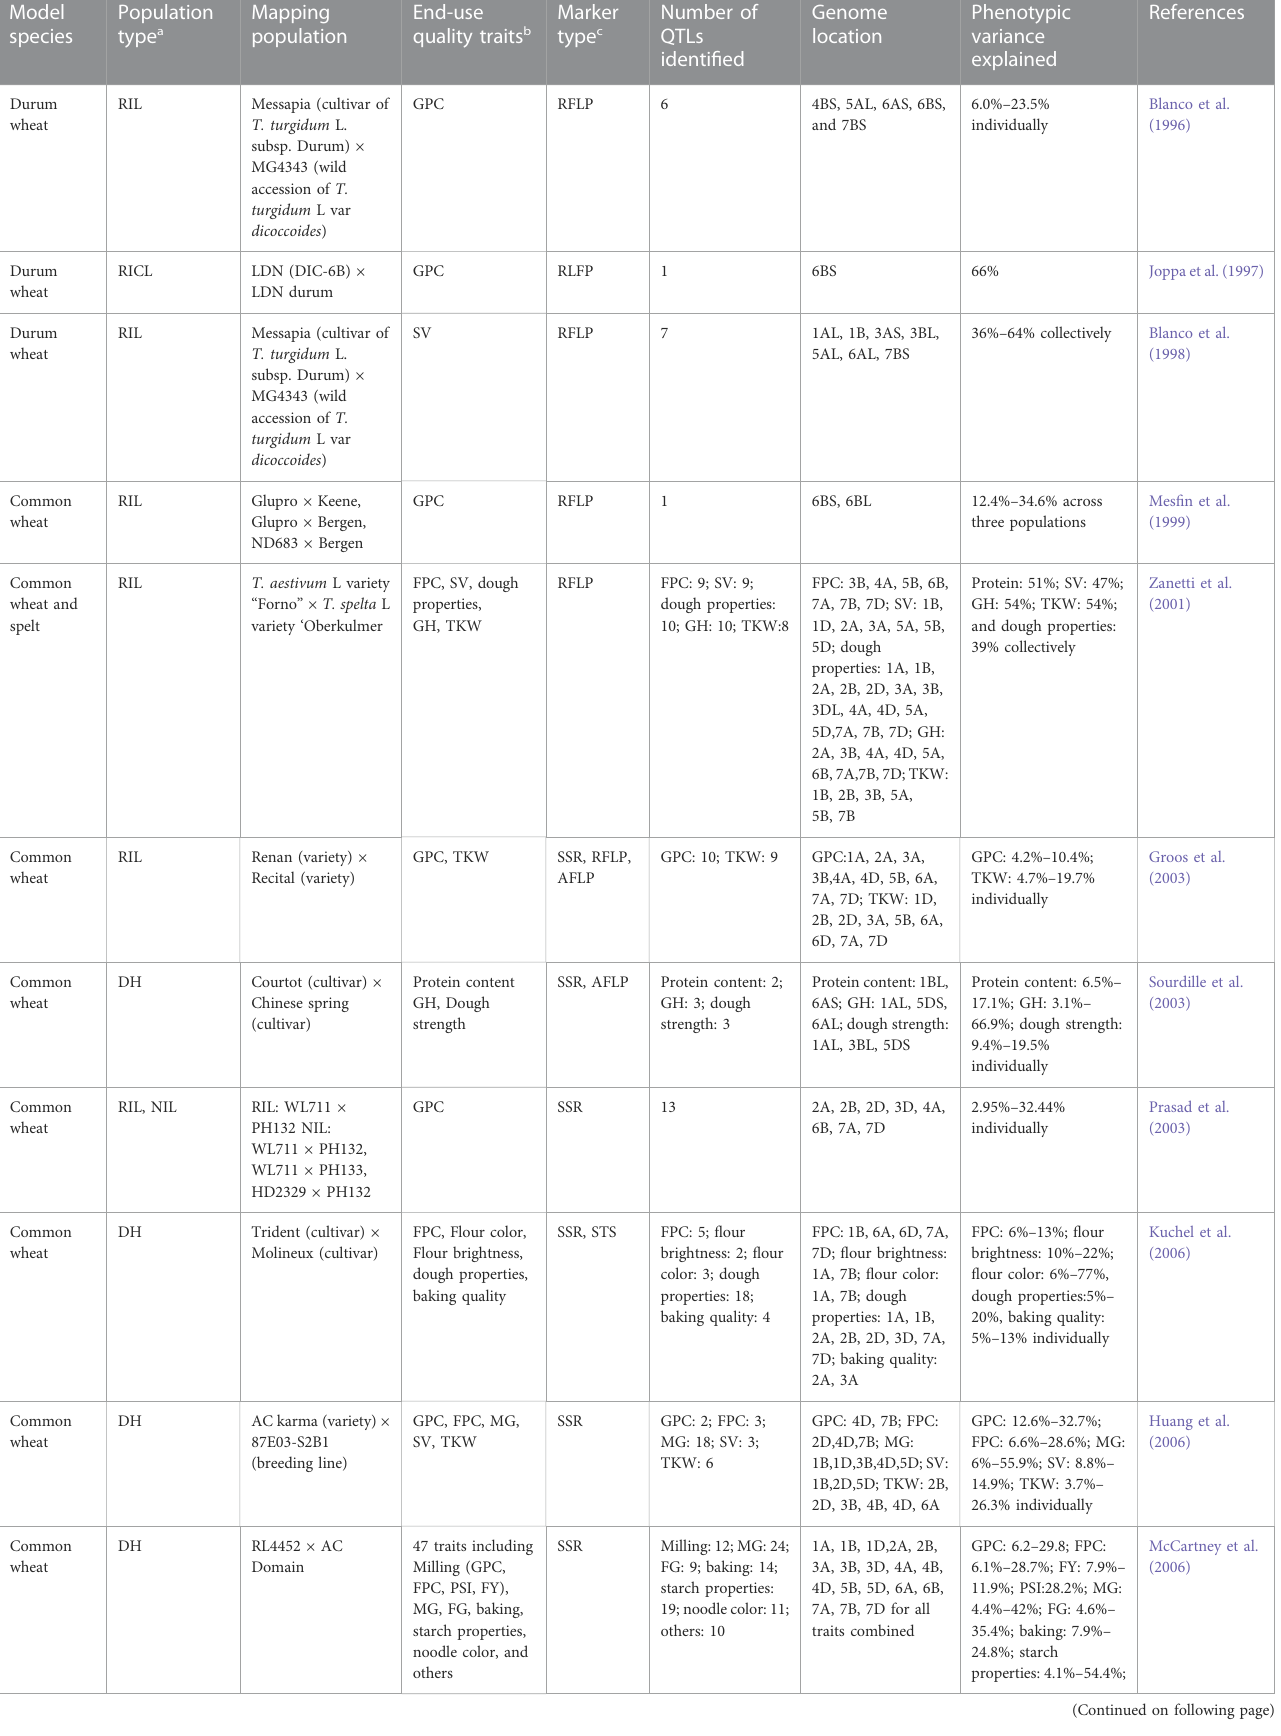
TABLE 1 Summary of representative QTL identi fi cation studies for end-use quality traits in wheat. Phenotypic variance is indicated collectively for all the QTLs or individually for each QTL. Model